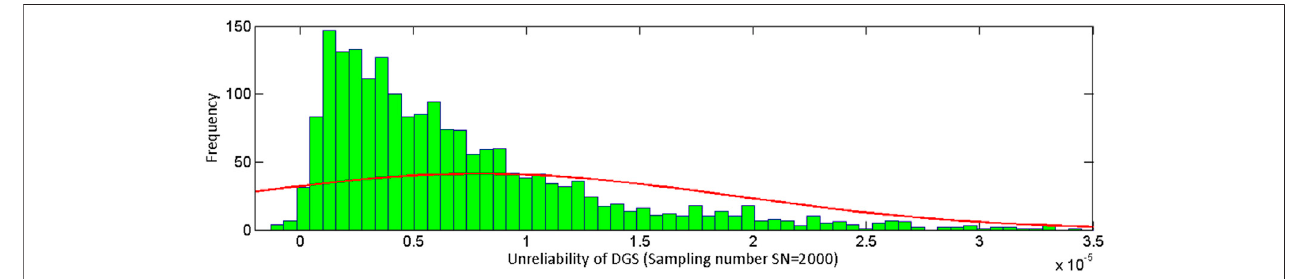
FIGURE 9 | Frequency histogram for DGS unreliability (sampling number SN (cid:1) 2000).